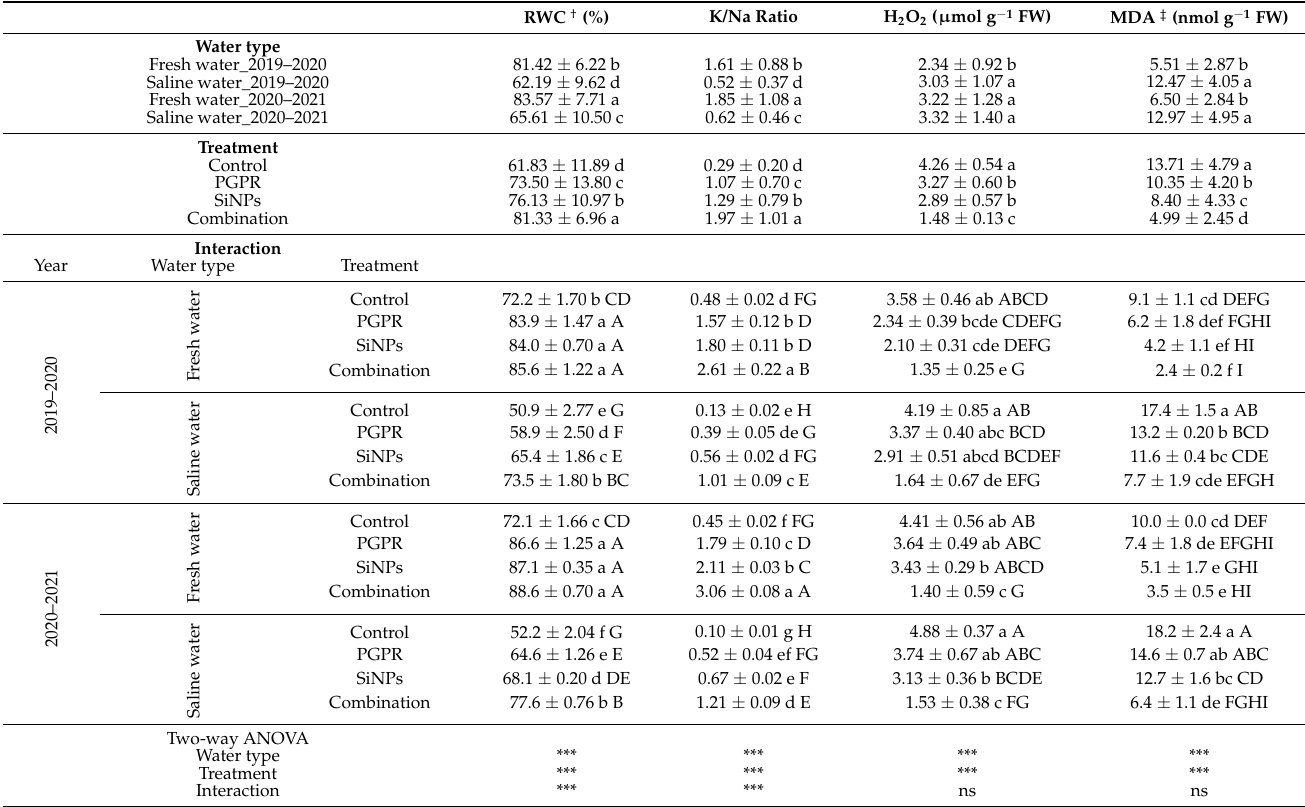
Table 3. Physiological response of barley ( Hordum vulgare L., cv. Giza 132) plants cultivated in salt-affected soil to the exogenous application of plant growth-promoting rhizobacteria (PGPR; Azotobacter chroococcum SARS 10 and Pseudomonas koreensis MG209738), silica nanoparticles (SiNPs), and their combination to alleviate the detrimental impacts of saline irrigation water during two consecutive